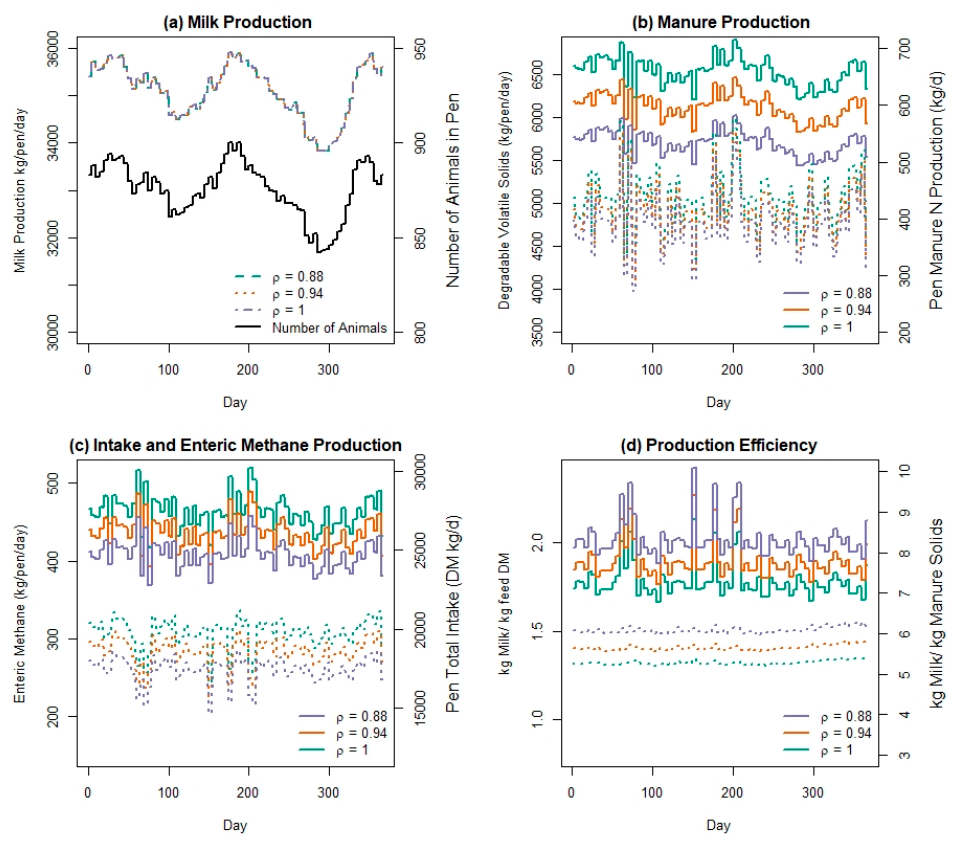
Figure 5. Daily predicted outputs of ( a ) milk production and number of lactating animals, ( b ) manure volatile solids and nitrogen, ( c ) enteric methane and pen intake, and ( d ) production efficiency from a herd of lactating Holstein cows simulated in the Ruminant Farm Systems Animal Module with 3 levels of feed efficiency as implemented by 3 different values of ρ , which is the proportion of expected feed intake consumed for a constant production level. Solid lines: ( b ) Volatile Solids, ( c ) Enteric Methane, ( d ) ratio of Milk:Feed; dotted lines: ( b ) Manure N, ( c ) Intake, ( d ) ratio of Milk:Manure.